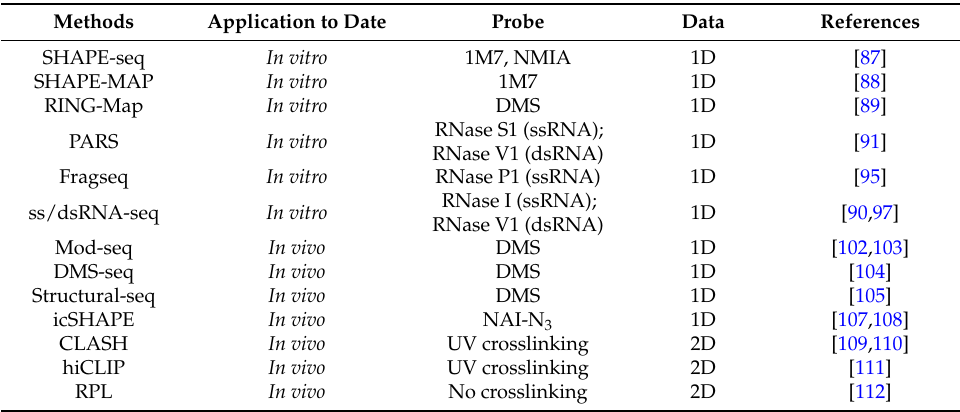
Table 1. Summary of RNA structural probing